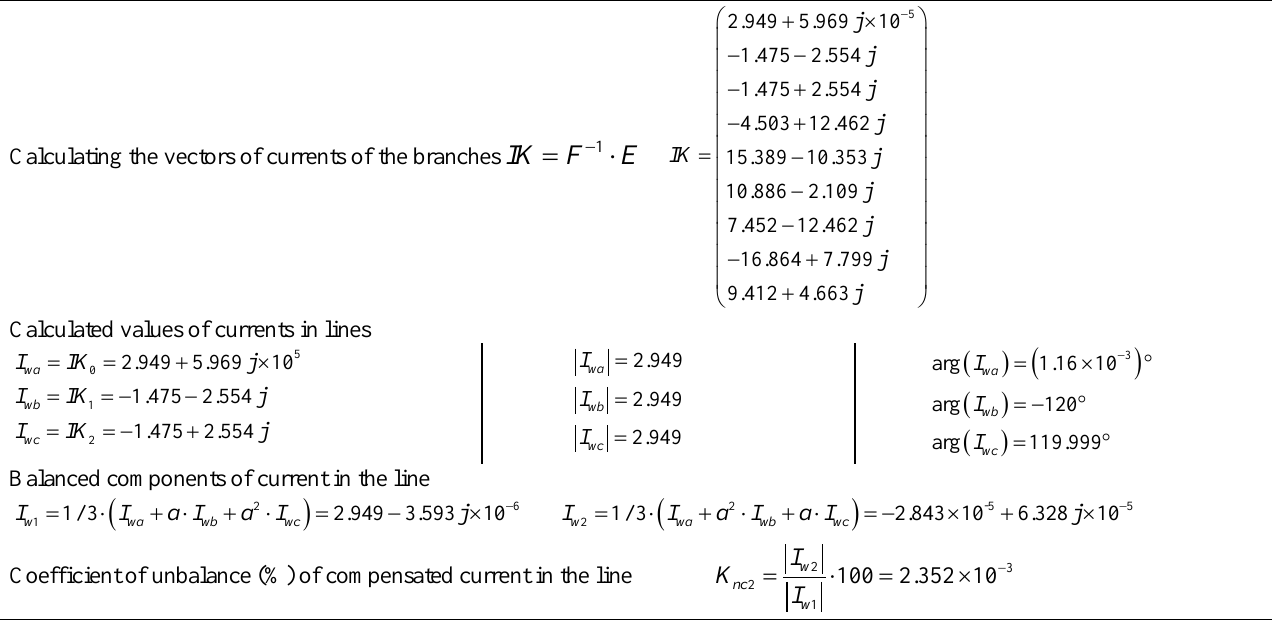
Table 5. The results of calculation and assessment of coefficient of unbalance of lines currents with elaborated compensation